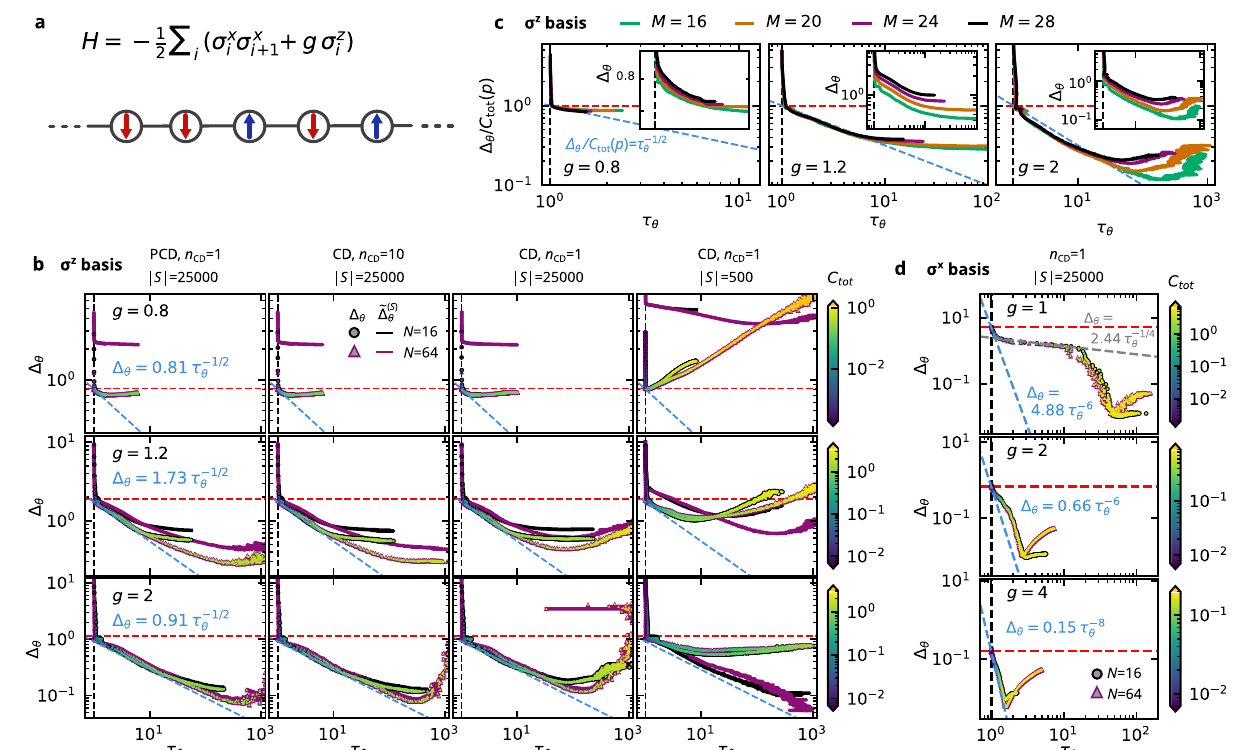
Fig.2|RBMlearningcharacteristicsforaquantum-statetomographytask. The ground state of the transverse- fi eld Ising chain with M lattice sites is recon- structed from magnetization measurements along a fi xed axis, namely the z direction in b , c and the x direction in d . Thus the ground state is represented in the eigenbases of the σ z i or σ x i Pauli operators associated with each lattice site. Training used contrastive divergence (CD) or persistent CD (PCD) with η =10 − 3 , B = 100. a Hamiltonian and sketch of the transverse- fi eld Ising chain, whose ground-state wave function ψ ( x ) is the square root of the target dis- tribution p ( x ). b Exact loss Δ θ (points) and empirical loss ~ Δ ð S Þ θ (solid lines) vs. autocorrelation time τ θ de fi ned in (6), utilizing PCD ( fi rst column) or CD (last three columns), n CD = 10 (second column) or n CD = 1 (all other columns) and ∣ S ∣ = 25,000 ( fi rst three columns) or ∣ S ∣ = 500 (fourth column) training sam- ples, measured in the σ z basis, for several different values of the magnetic fi eld